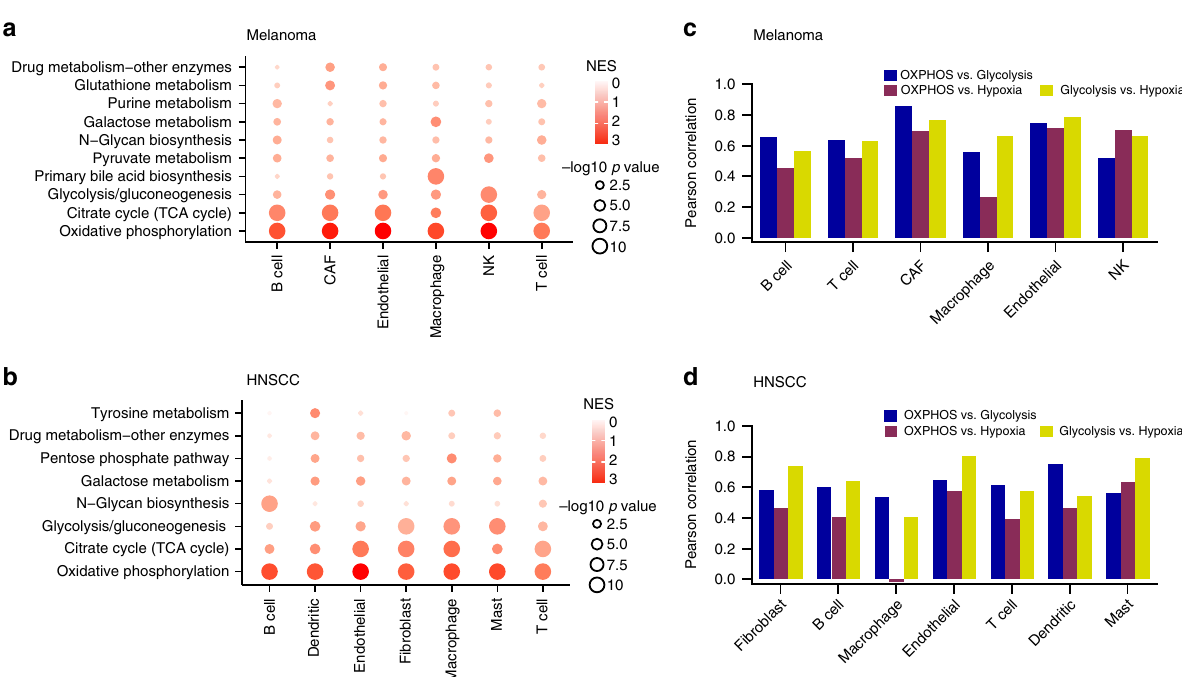
Fig. 4 Metabolic heterogeneity of non-malignant cells. a Metabolic pathways enriched in genes with highest contribution to the metabolic heterogeneities among different types of non-malignant cells from the melanoma dataset. b Pearson ’ s correlation coef fi cients between the activities of glycolysis, OXPHOS and response to hypoxia in non-malignant cells from the melanoma dataset. c Same as in a but for the HNSCC dataset. d Same as in b but for the